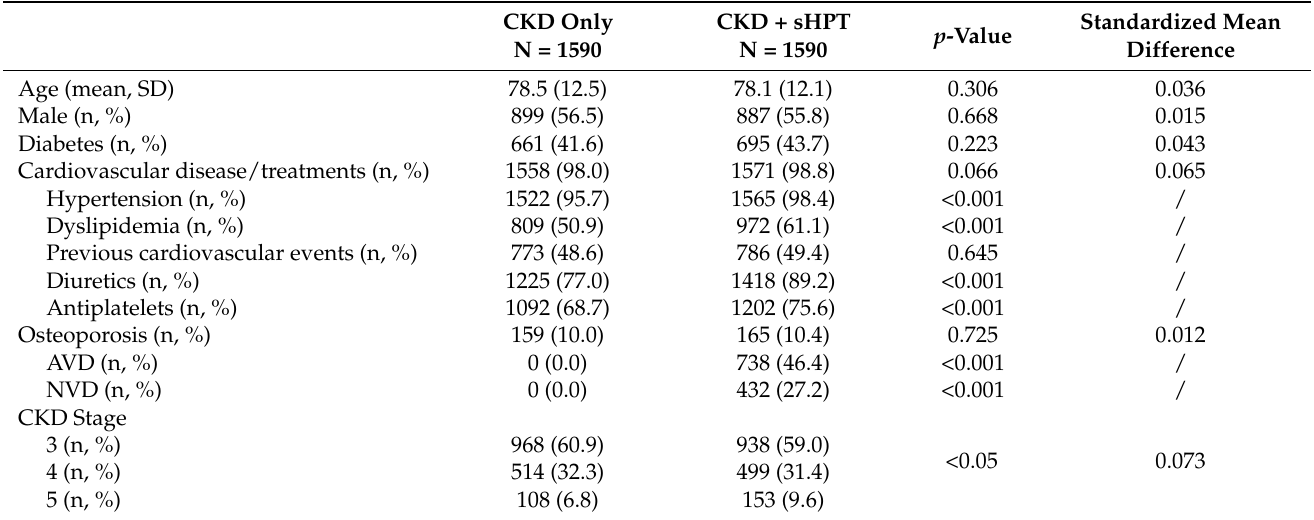
Table 1. Demographic and clinical characteristics at baseline of patients with a diagnosis of CKD without (CKD-only) and with sHPT diagnosis (CKD + sHPT), post PSM. CKD Only CKD + sHPT p N = 1590 N = 1590